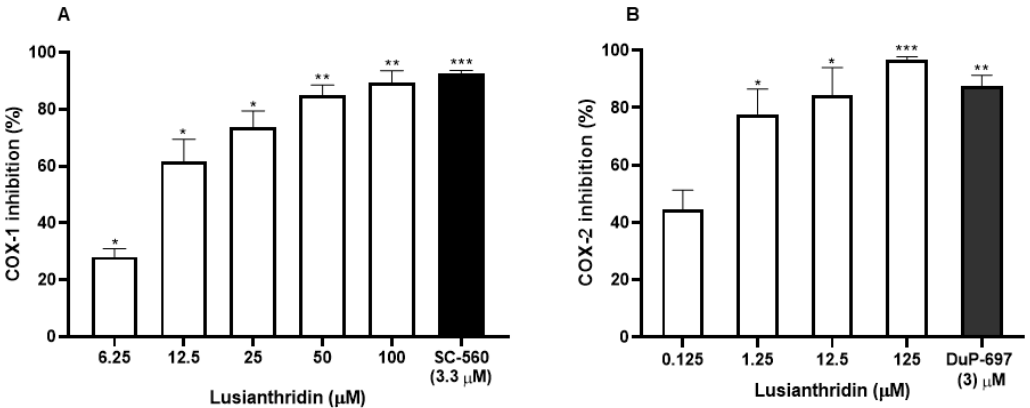
Figure 5. The inhibitory effects of various concentrations of lusianthridin on the activities of ( A ) COX-1 and ( B ) COX-2 enzymes. Tested compounds were incubated directly with COX-1 or COX-2 in the assay buffer for 5 min and then the activities were measured by a COX fluorescent inhibitor screening assay kit. SC-560, a COX-1 selective inhibitor, and DuP-697, a COX-2 selective inhibitor, were used as positive controls. Data are presented as means ± SEMs ( n = 3). * p < 0.05, ** p < 0.001, *** p < 0.0001 compared with control.